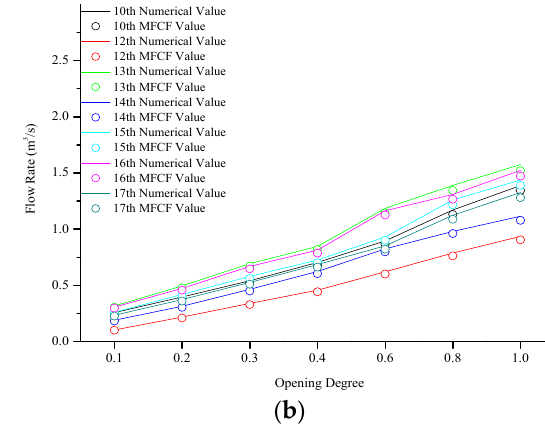
Figure 8. The relationship between the numerical results of the flow rate and the results of the calculation formula for water measurement specifications: ( a ) 1st to 9th branches under the conditions of opening degrees of 0.1, 0.2, 0.3, 0.4, 0.6, 0.8, and 1.0; ( b ) the 10th to 17th branches. “WMSCF” represents the water measurement specification calculation formula, and “MFCF” represents the modified flow calculation formula.